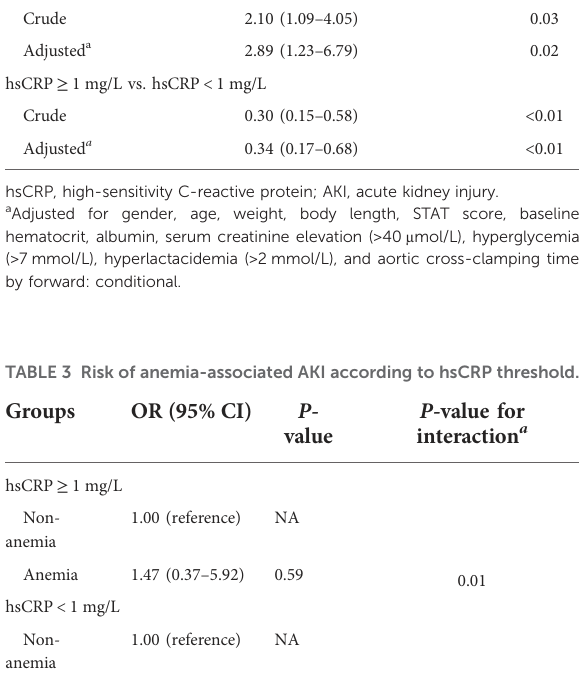
FIGURE 1 Perioperative hemoglobin and hematocrit of the two groups at different time points. T0, before surgery; T1, bypass hypothermia; T2, bypass rewarming; T3, weaning of bypass. * P